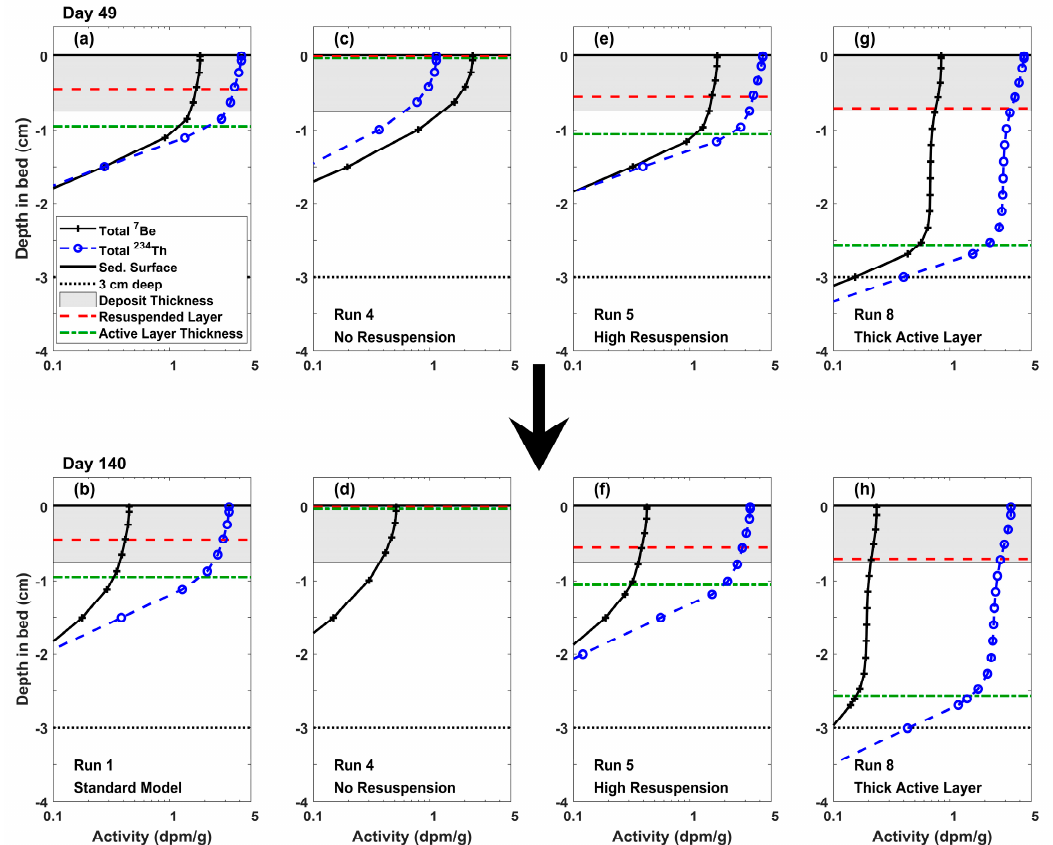
Figure 5. Radioisotope profiles that had ( a , b ) resuspension depth of 0.46 cm (Case 1), ( c , d ) no resuspension (Case 4), ( e , f ) resuspension depth of 0.56 cm (Case 6), and ( g , h ) a thick active layer (Case 8). Top row shows results on day 49; while bottom row shows day 140. Horizontal lines as described in Figure 3. Gray boxes represent the initial extents of the flood deposit, red lines denote depth of resuspended layer, green lines denote depth of maximum active layers. The bed height after deposition was defined as z bed = 0. Note that day 140 for Run 4 ( d ) has zero 234 Th, which decayed below the detection limit by this time.